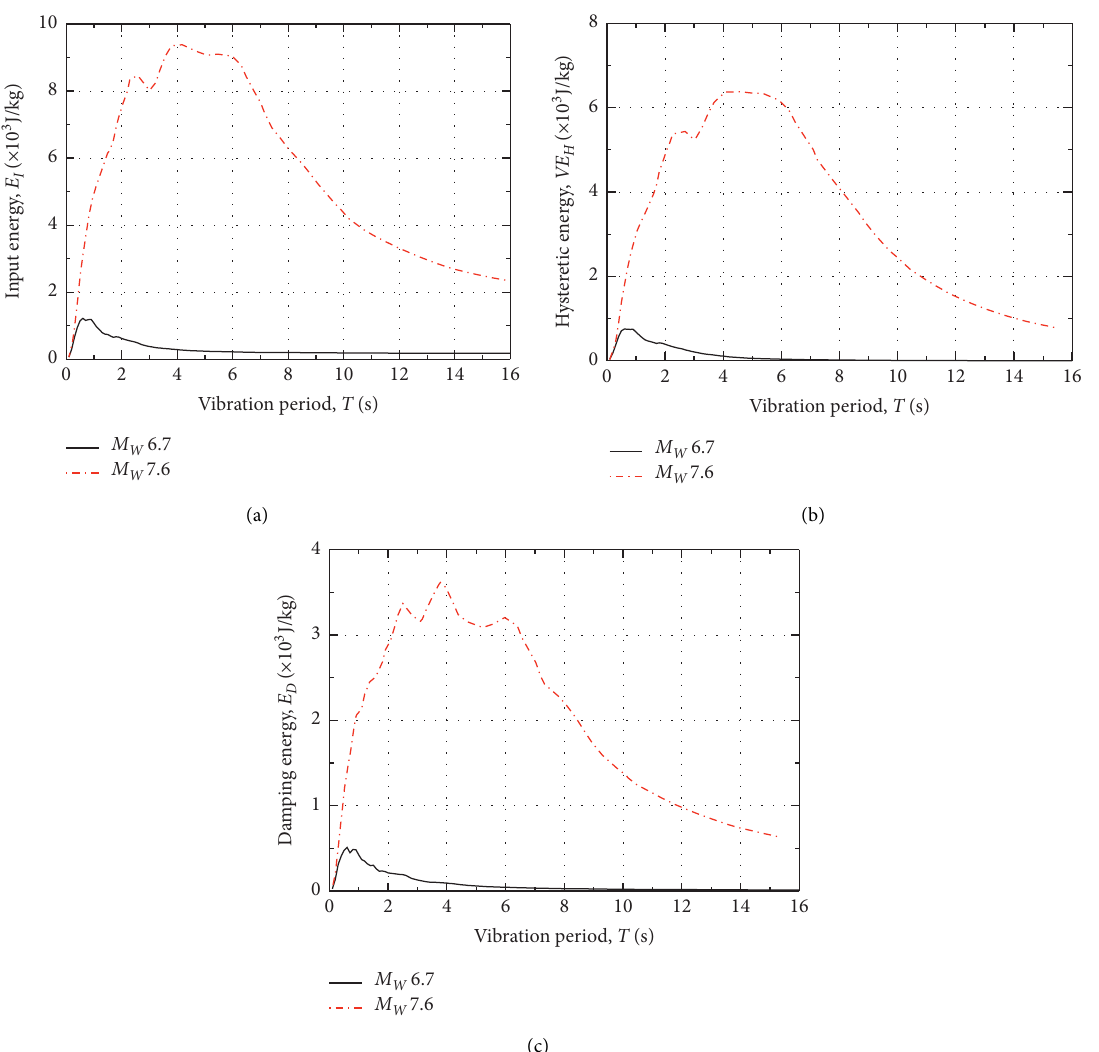
Figure 4: Energy response spectra affected by earthquake magnitude under near-fault pulse-like ground motions. (a) Input energy. (b) Hysteretic energy. (c) Damping